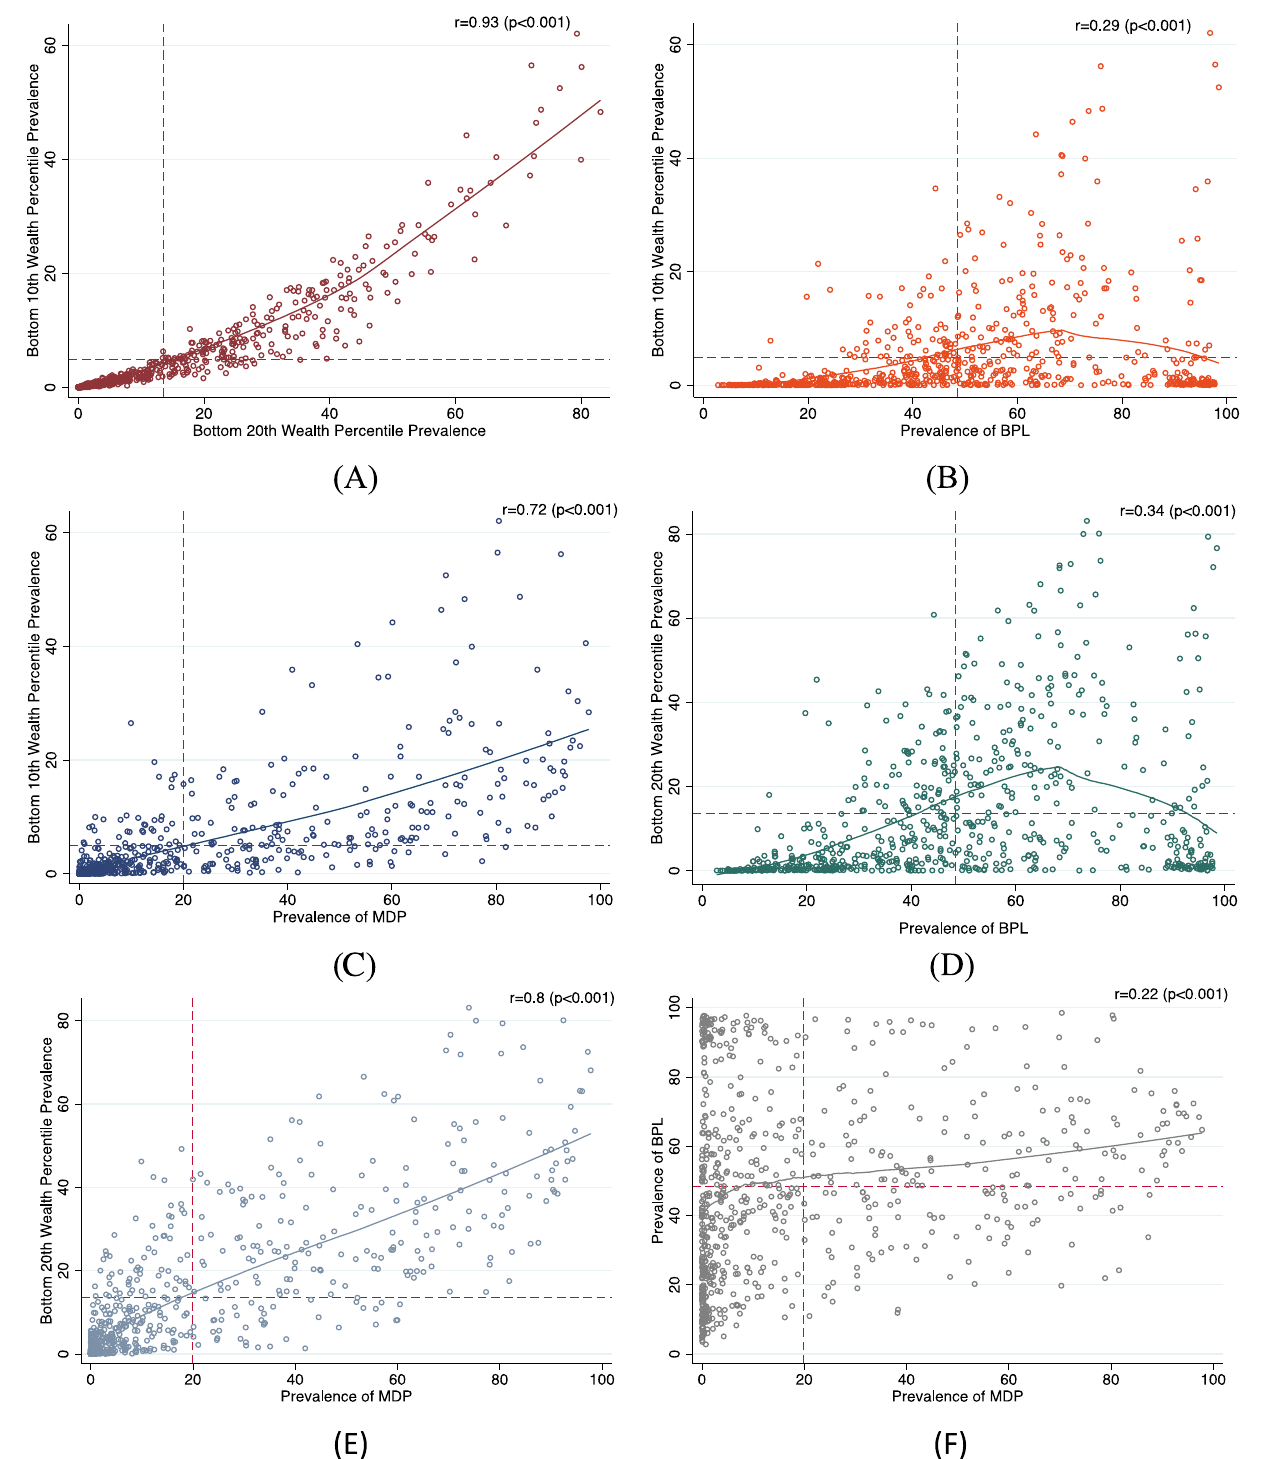
Fig. 2 Correlation plots for the district-level prevalence between the four measures of poverty. A Bottom 10th wealth percentile and bottom 20th wealth percentile. B Bottom 10th wealth percentile and BPL. C Bottom 10th wealth percentile and MDP. D Bottom 20th wealth percentile and BPL. E Bottom 20th wealth percentile and MDP. F BPL and